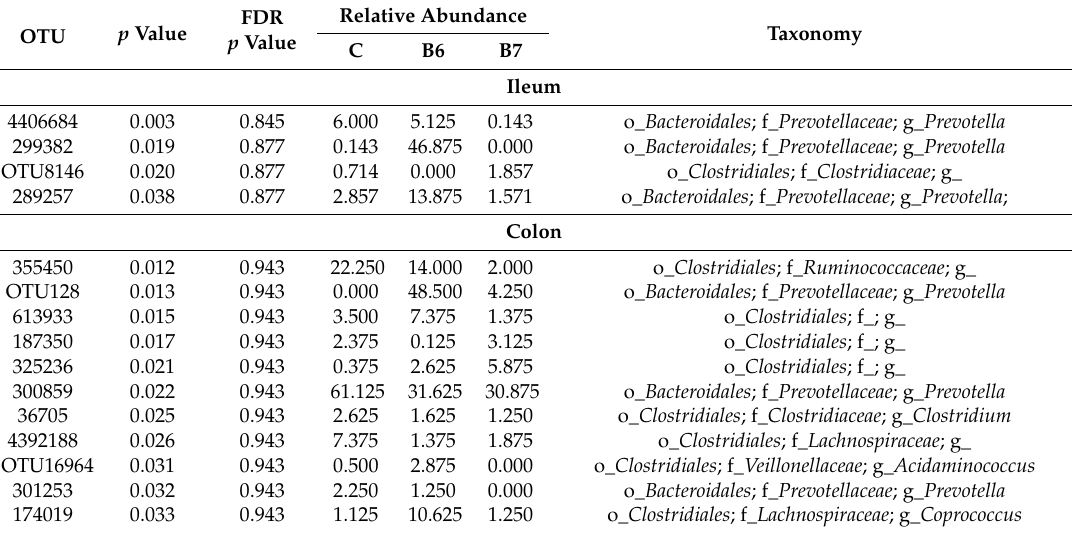
Table 6. Relative abundance of the operational taxonomic units